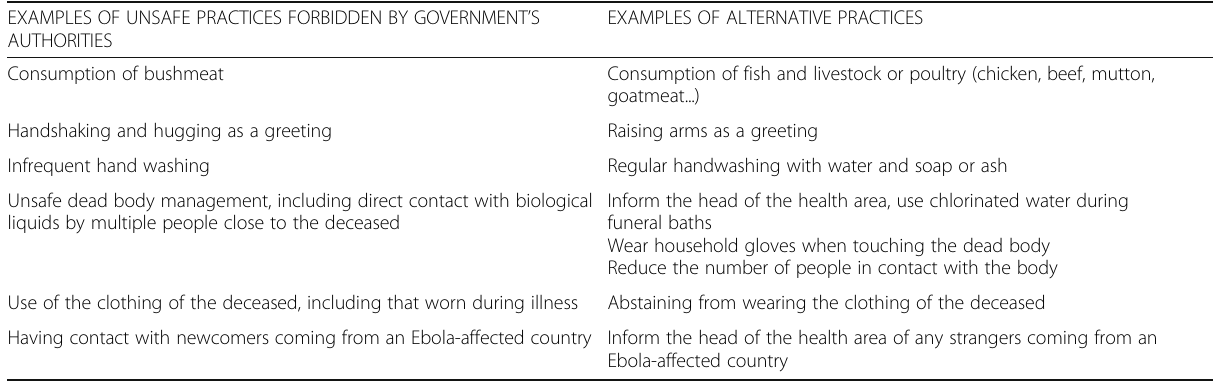
Table 1 Unsafe practices and proposed alternative practices EXAMPLES OF UNSAFE PRACTICES FORBIDDEN BY GOVERNMENT ’ S